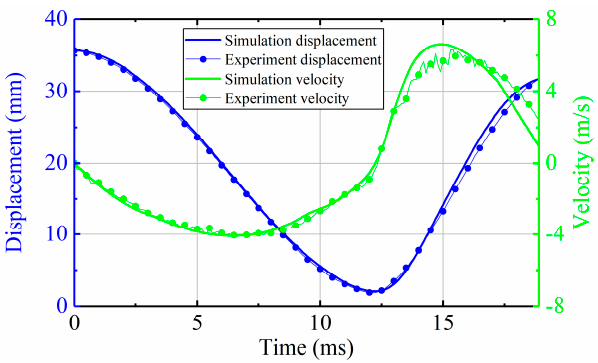
Figure 13. The piston motion verification (stable operation).